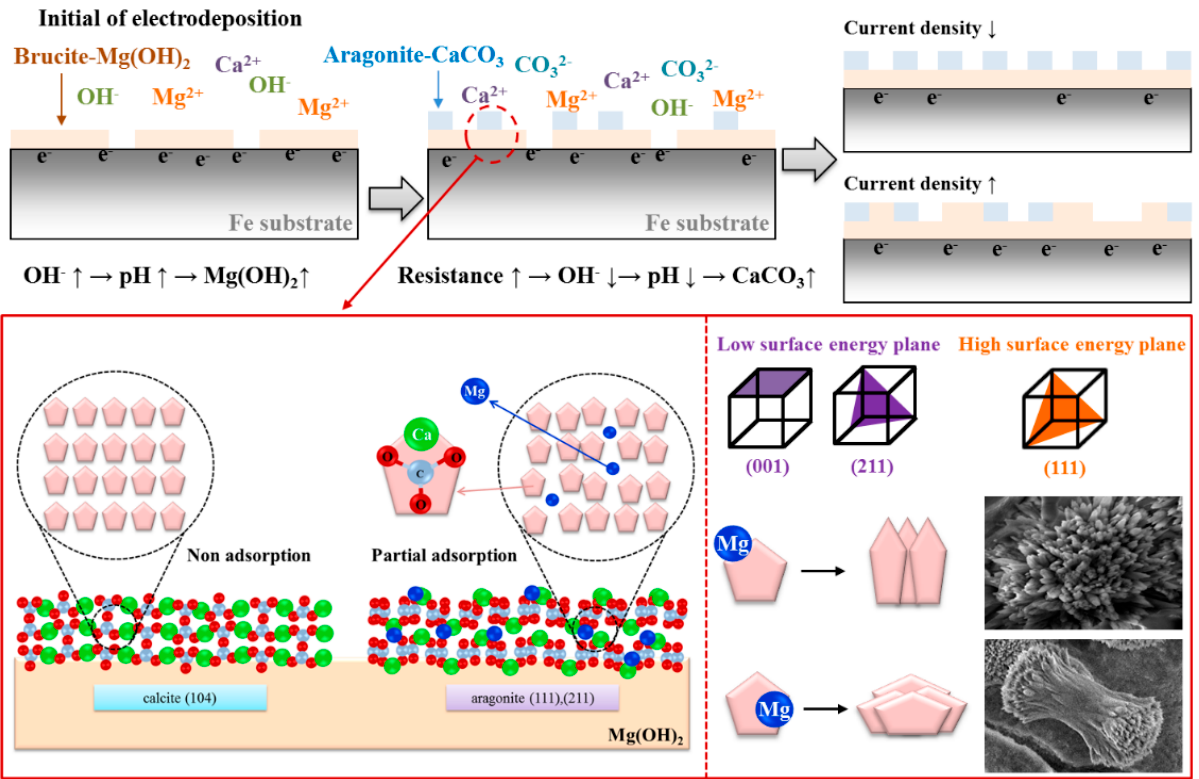
Figure 8. Formation mechanism of calcareous deposit films according to the composition and crystal structure.